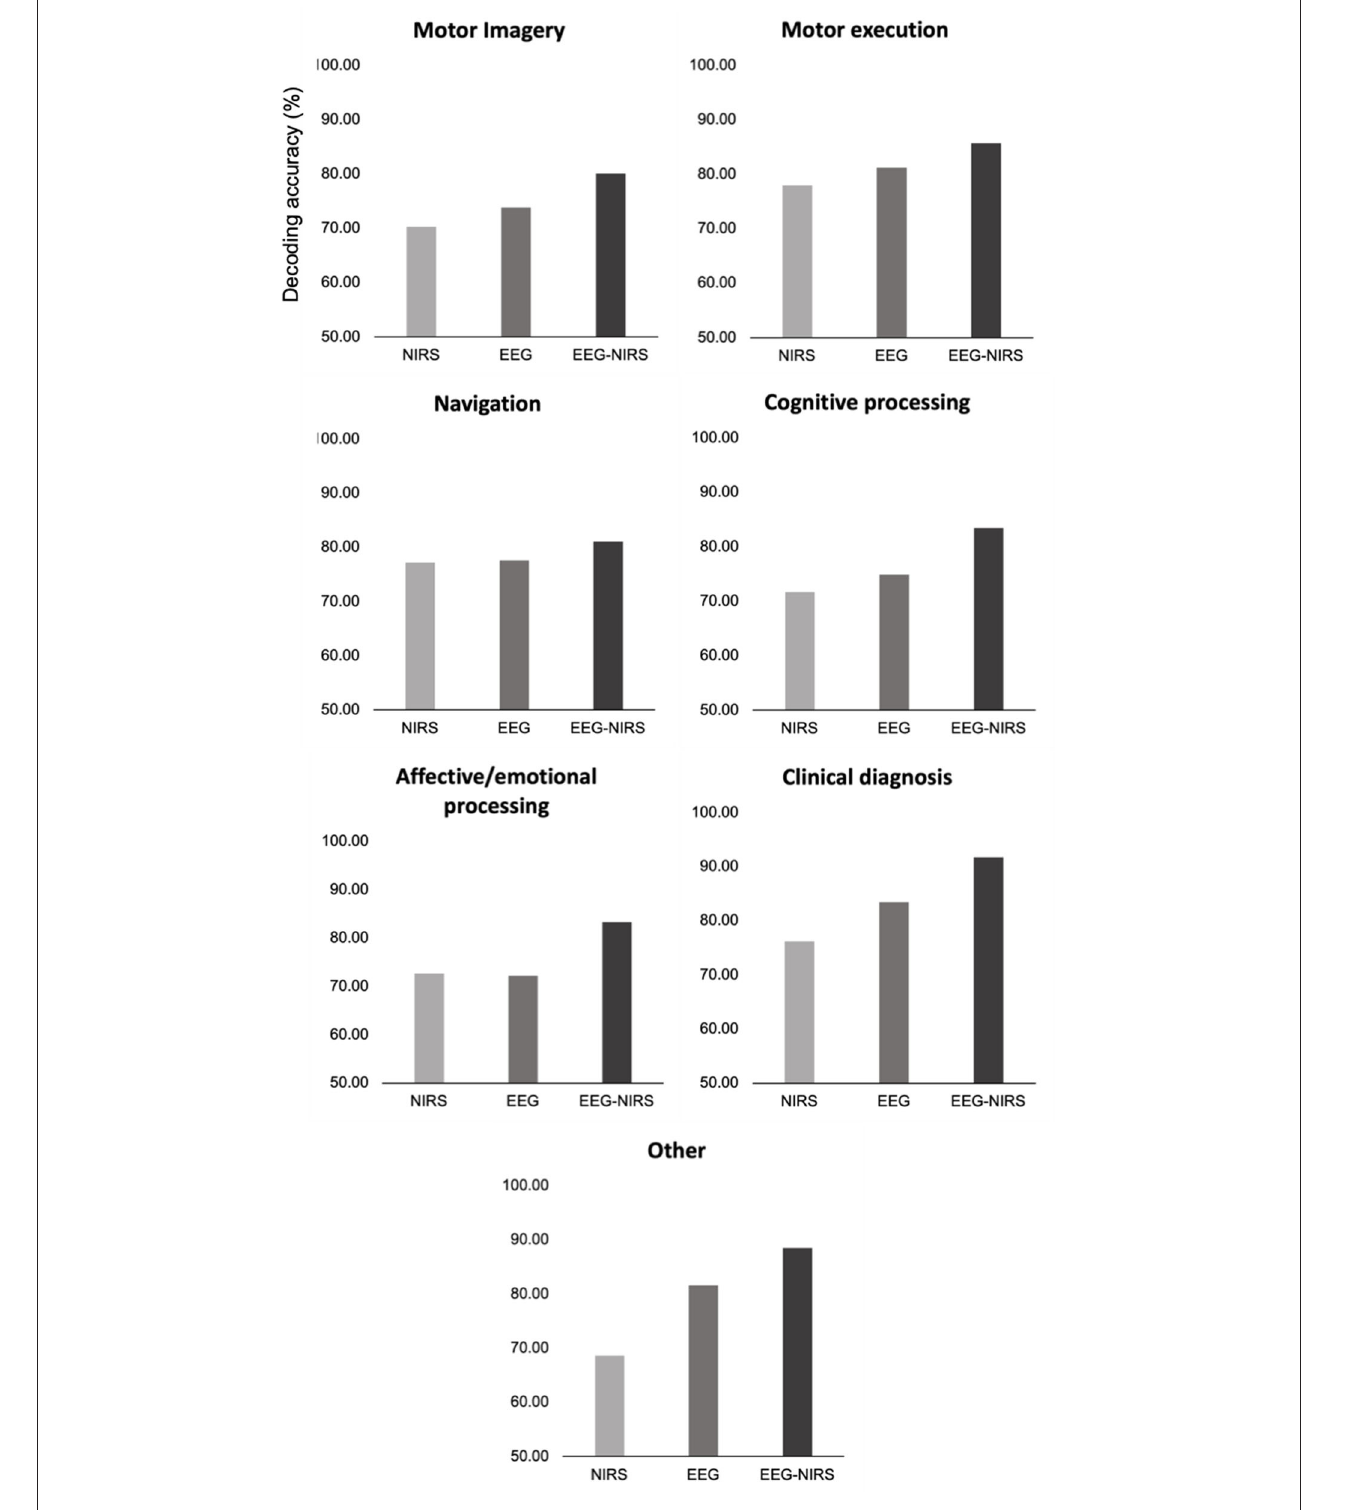
FIGURE 2 | Differences in decoding accuracy between unimodal NIRS, unimodal EEG, and bimodal EEG-fNIRS across the seven paradigms considered. Scores were obtained by averaging percent decoding accuracy scores reported for each method by the studies reviewed in each category (see Tables 1 , 2 for detail). When more than one possible score was obtained for the same individual method (e.g., when comparing different decoding algorithms), the highest score was systematically chosen. Note that these graphs are displayed for visual presentation and not statistical inference.